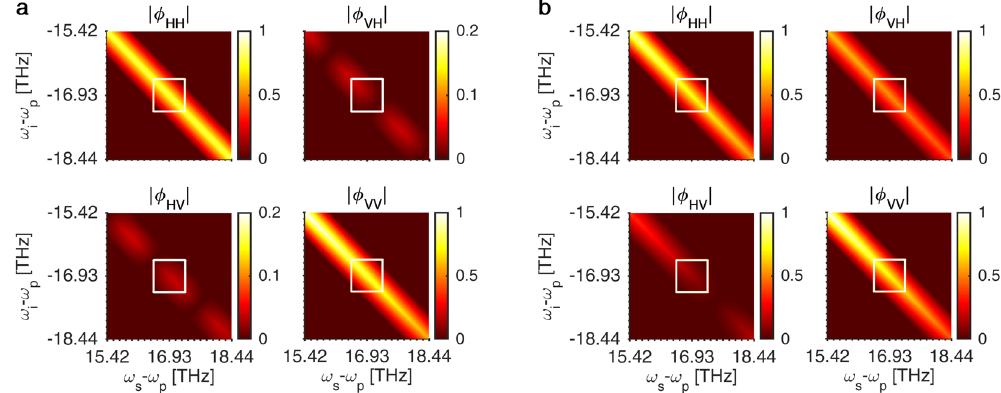
Figure 2. Magnitudes of effective, balanced biphoton wavefunctions as a result of two orthogonally-pumped SFWM processes in ( a ) the 700-nm-wide waveguide and ( b ) the 1,200-nm-wide waveguide.